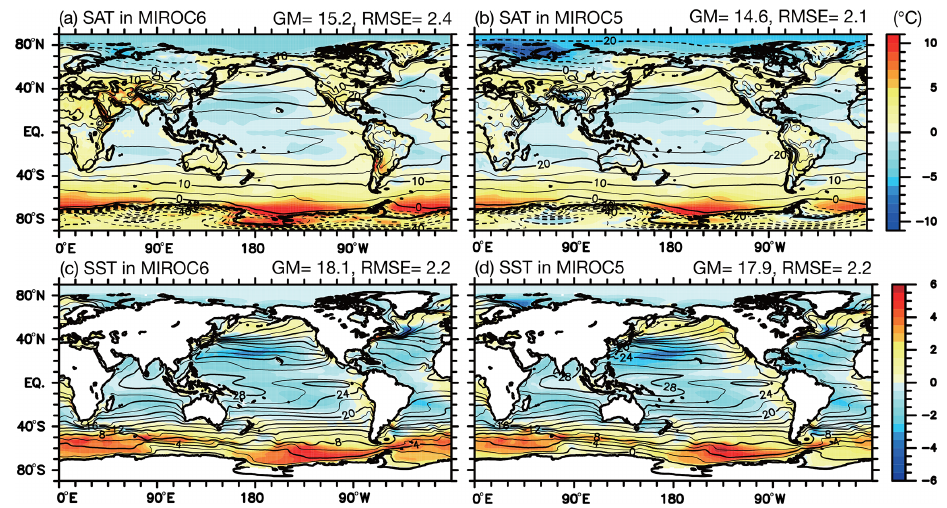
Figure 19. Same as Fig. 4, but for annual mean SAT (a, b) and SST (c, d) . ERA-I for the SAT and the ProjD for the SST are used as observations.